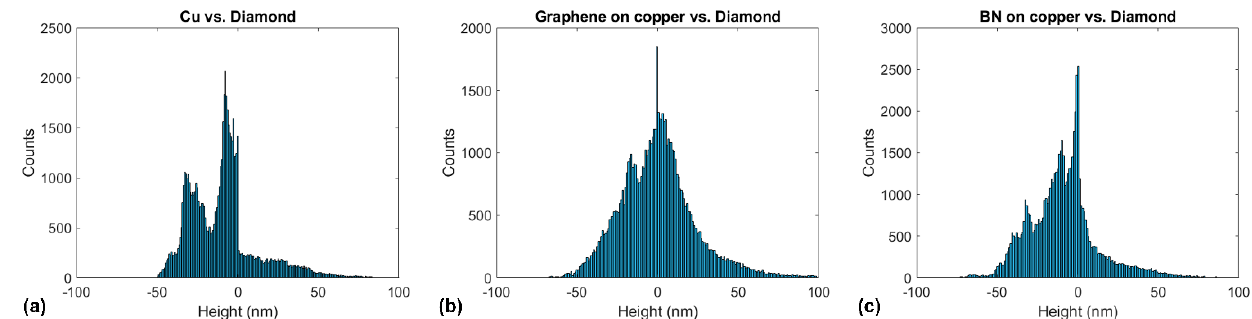
Figure 9. One-dimensional height distribution corresponding to the topographical images in Figure 6 for ( a ) annealed copper, ( b ) graphene-coated copper, and ( c ) BN-coated copper.